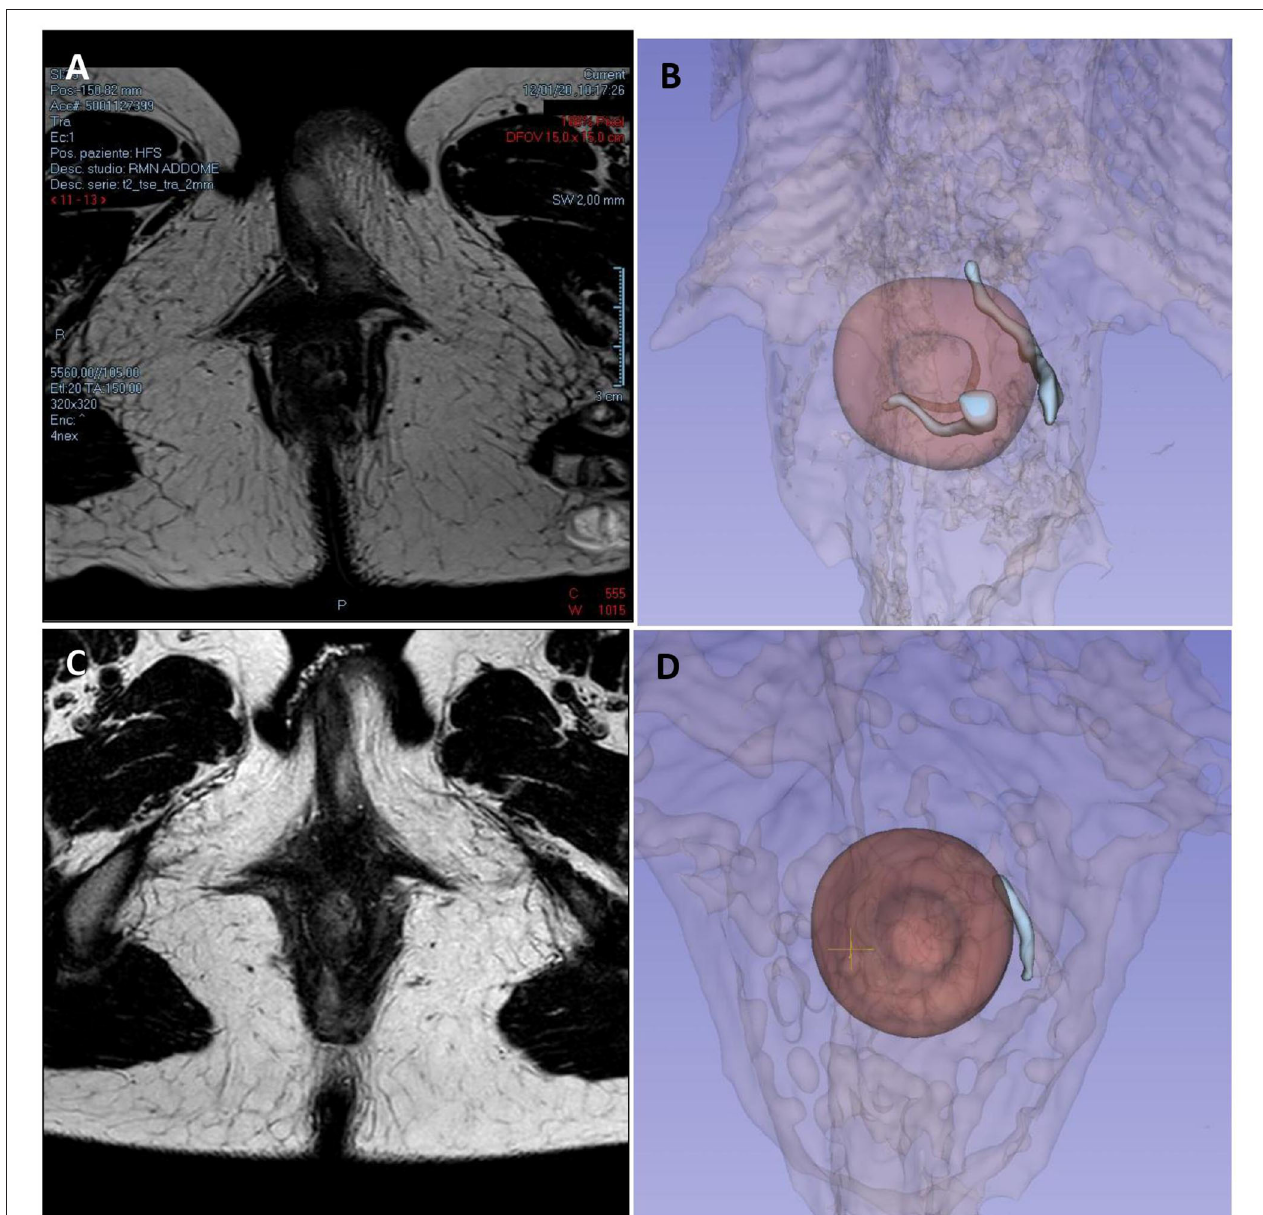
FIGURE 4 | Case 3 imaging pre- and post-surgery. Panels (A, B) show preoperative pelvic magnetic resonance imaging and 3D reconstruction showing a trans-sphincteric fistula starting from the left wall of the anal canal going forward up to the homolateral part of the vulva, with diffuse subcutaneous tissue imbibition but without abscesses, and a fistula in the posterior wall of the anal canal with an inter-sphincteric course. Panels (C, D) show 6-month MRI follow-up, with the persistence of the trans-sphincteric fistula toward the vulva but without signs of inflammation or collections.